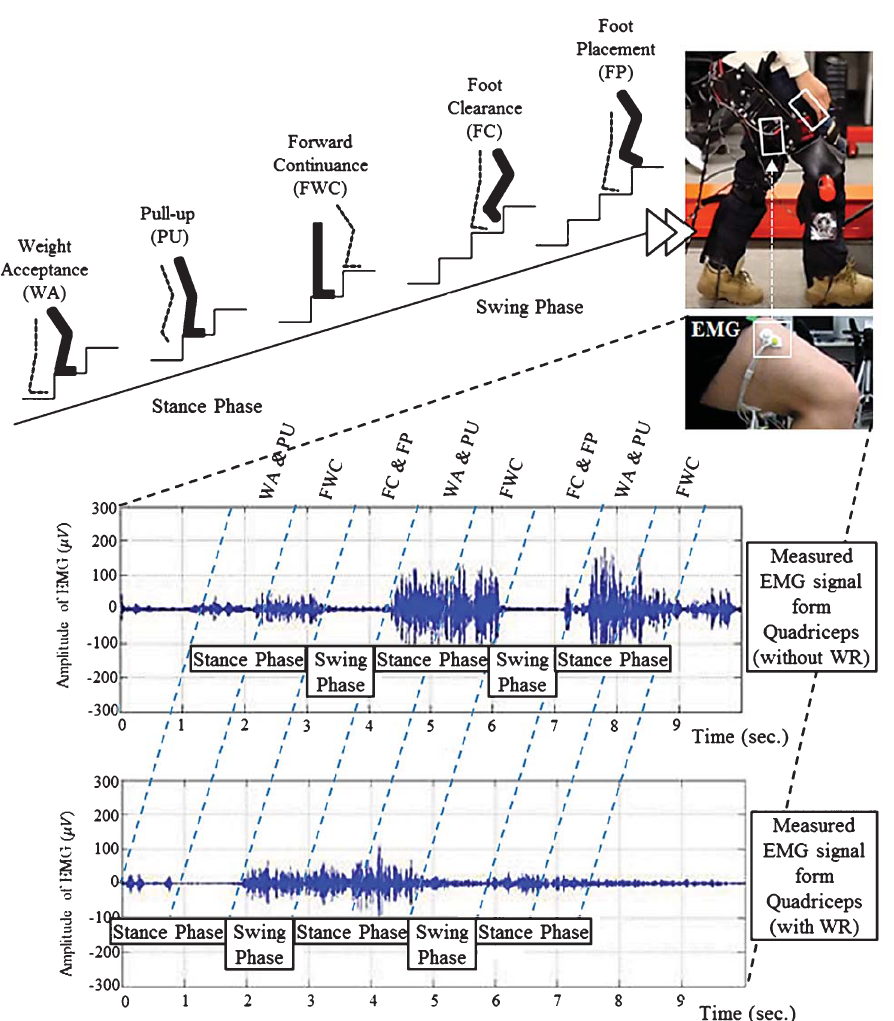
Fig. 12. Measurement results of the muscular activity of the wearer’s quadriceps before/after wearing the exoskeleton system (Power assisting ratio ∼= 0.5, Angular velocity of a knee joint=30rpm, WR: Wearable